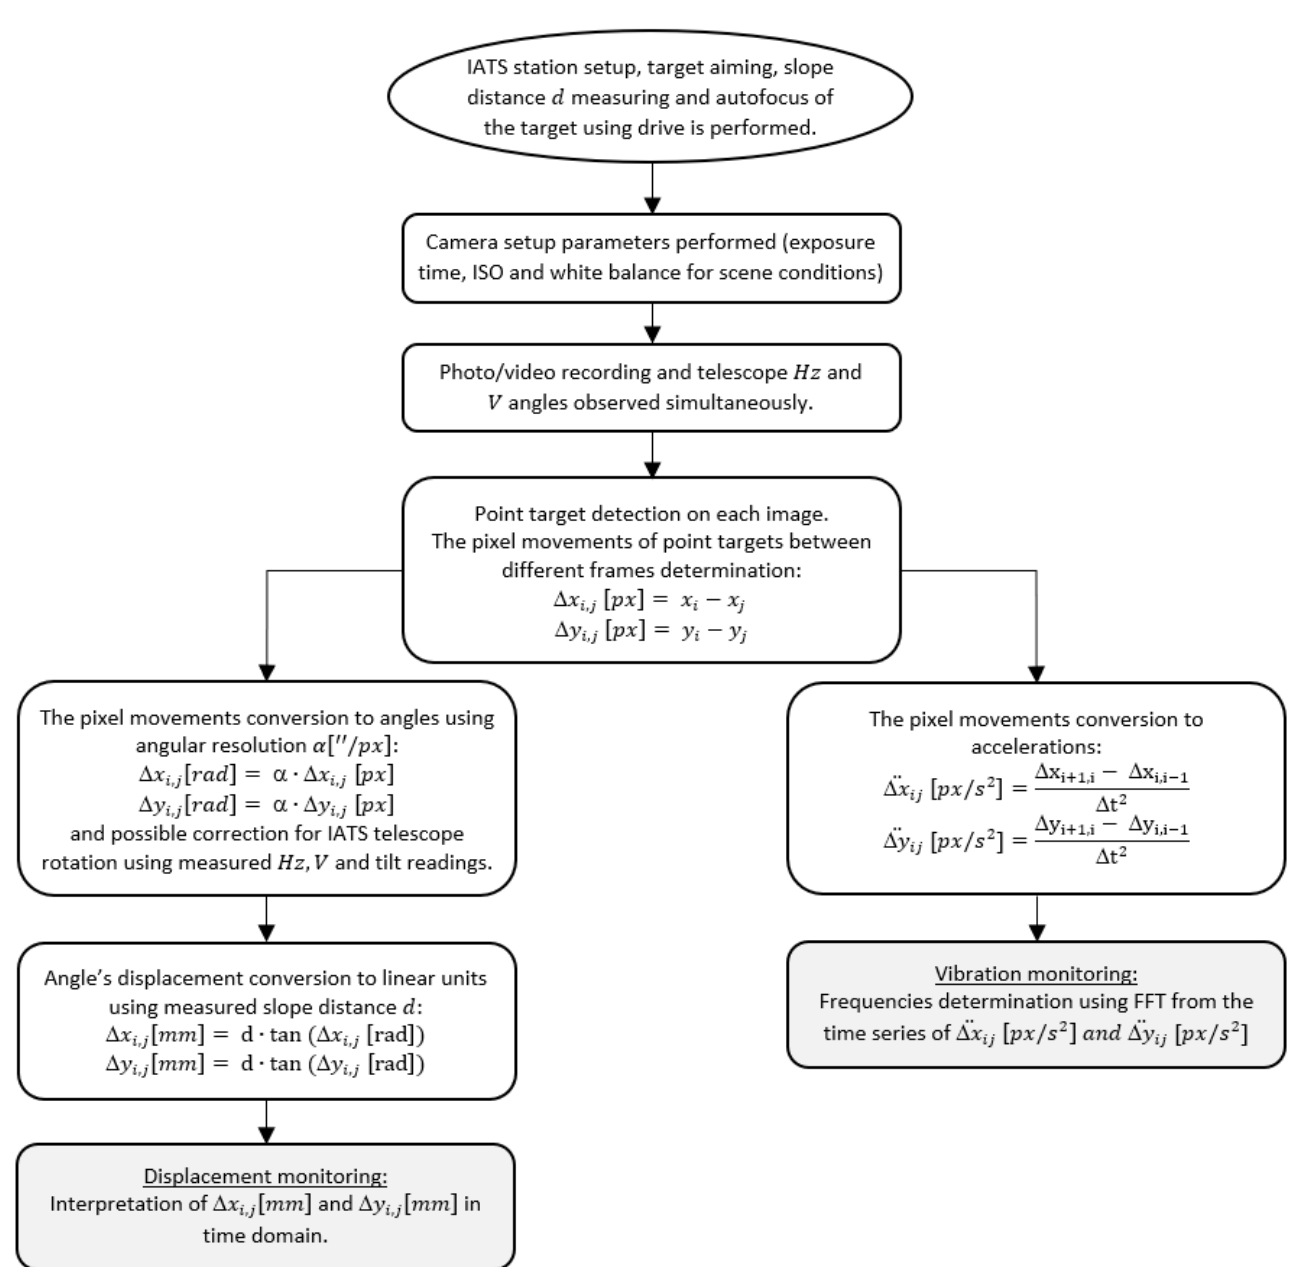
Figure 11. IATS measurements and data processing workflow for conducting displacement and vibration monitoring (structural health monitoring), modified for this study from [64].